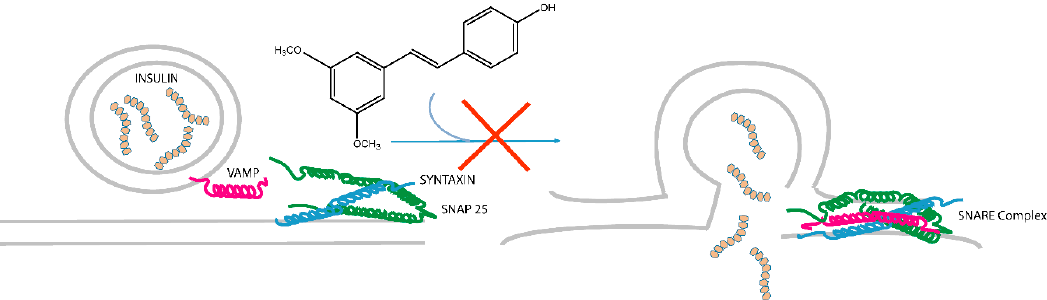
Figure 5. A schematic representation of PTS effect on the SNARE (Soluble NSF Attachment protein REceptor) complex assembly. PTS hampers (red cross) the assembly of STX-1/SNAP-25/